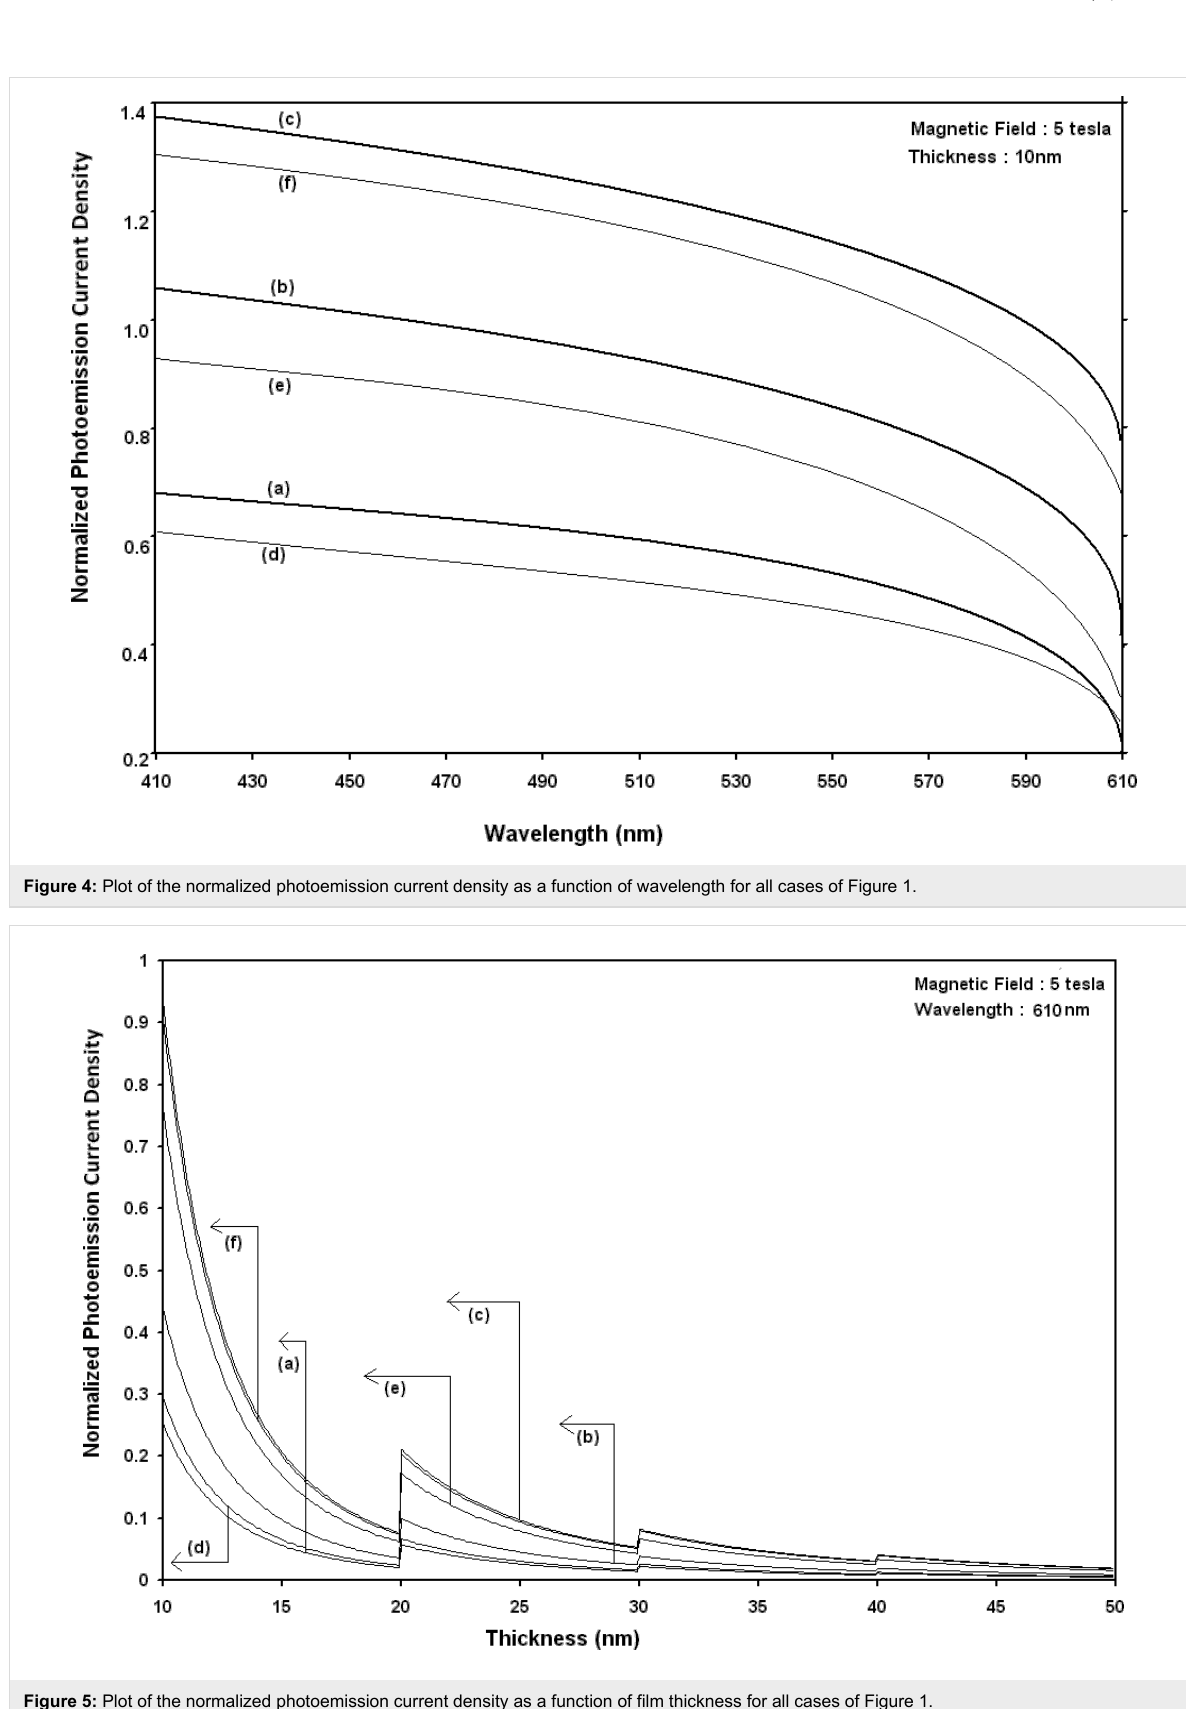
Figure 5: Plot of the normalized photoemission current density as a function of film thickness for all cases of Figure